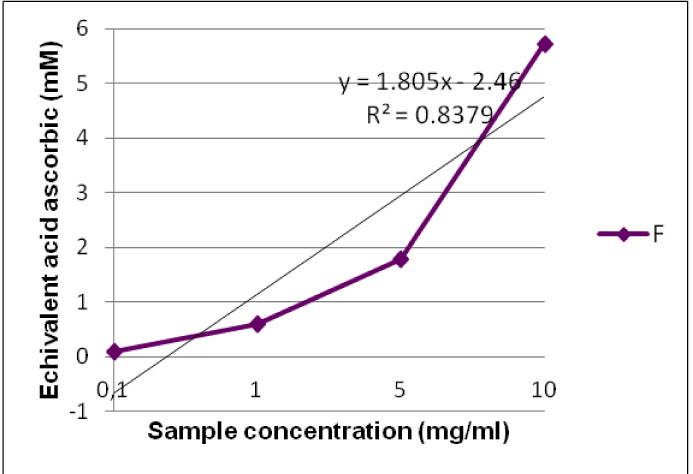
Figure 4. The total antioxidant capacity of formula F evidenced by the phosphomolybdic acid